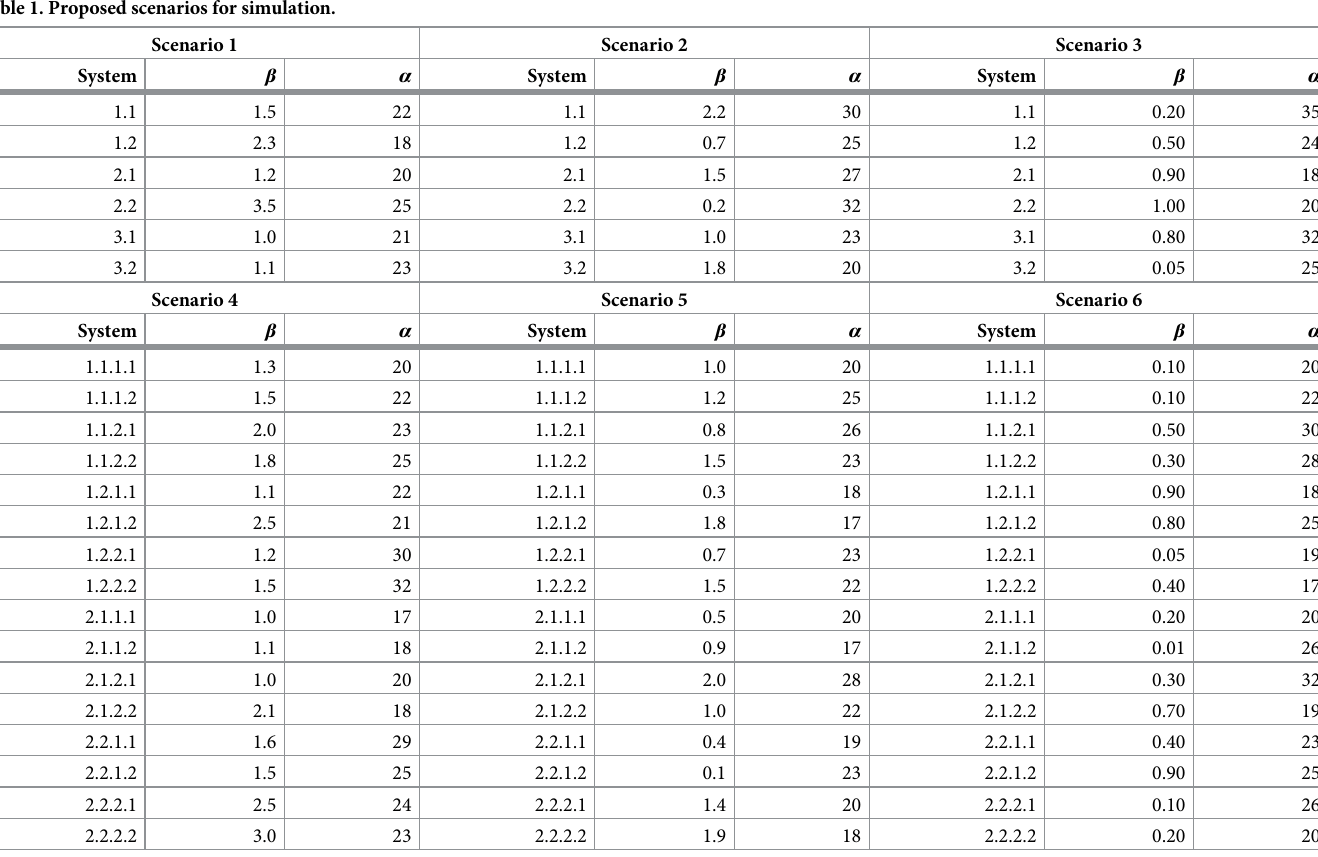
Table 1. Proposed scenarios for